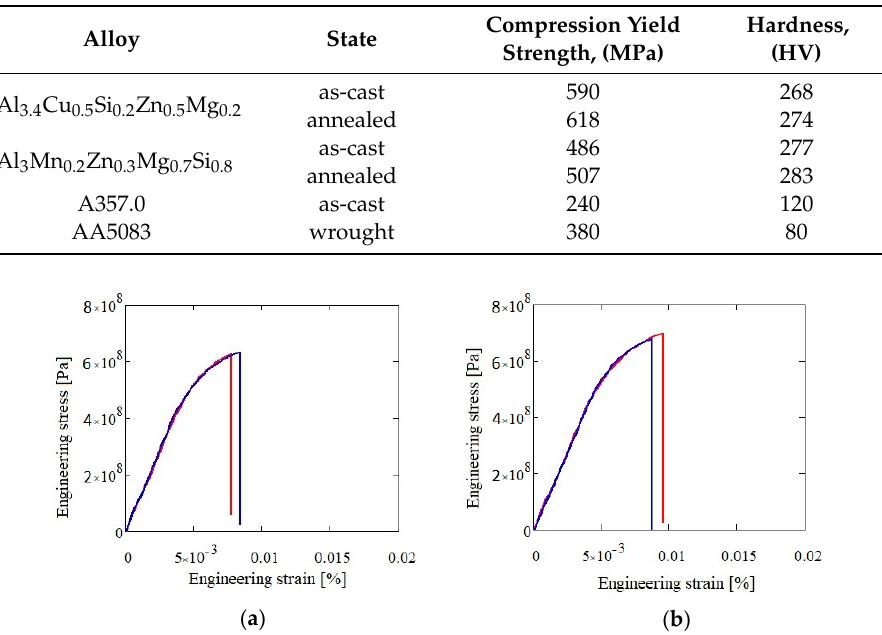
Table 7. Alloys chemical composition in weight percent.